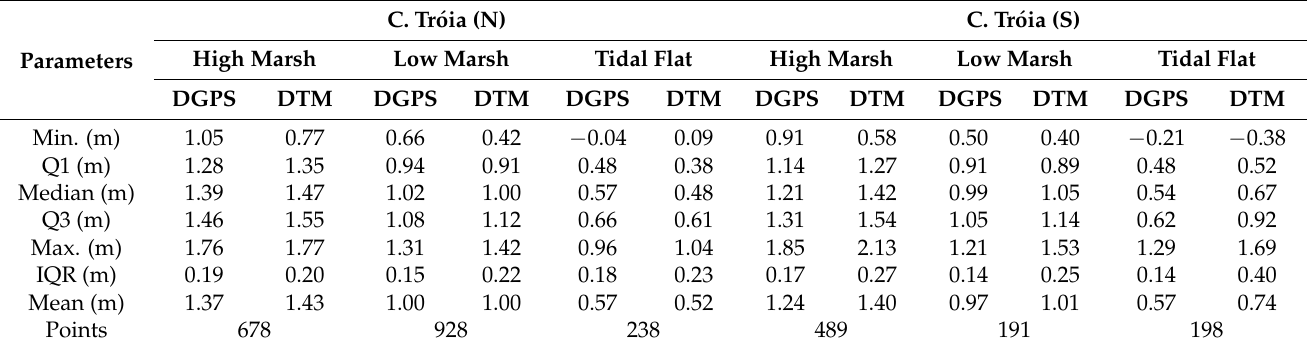
Table A1. Statistical parameters of high marsh, low marsh, and tidal flat heights for C. Tr ó ia (N) and C. Tr ó ia (S), considering DGPS and DTM.